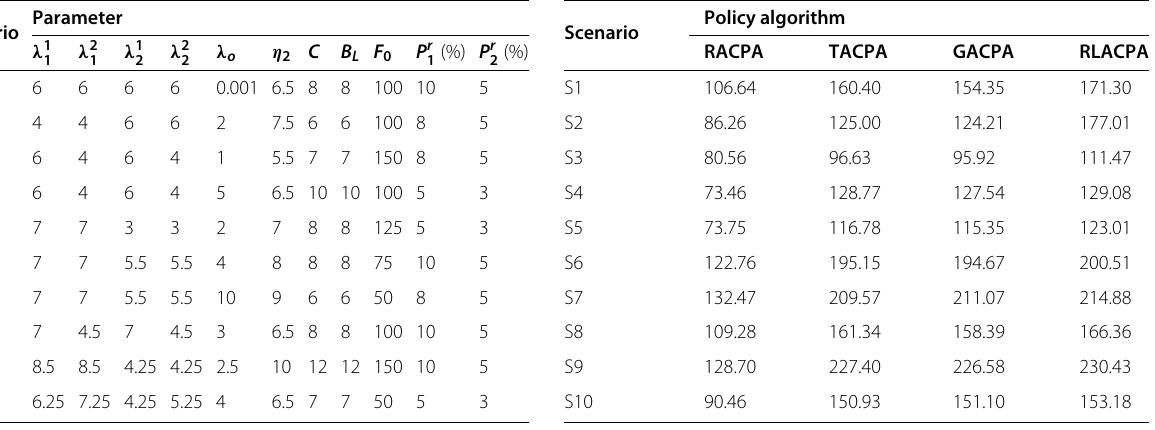
Fig. 16 SR and RPs under different f c 1 . This figure shows the impacts of the cost coefficient resources on the evaluation